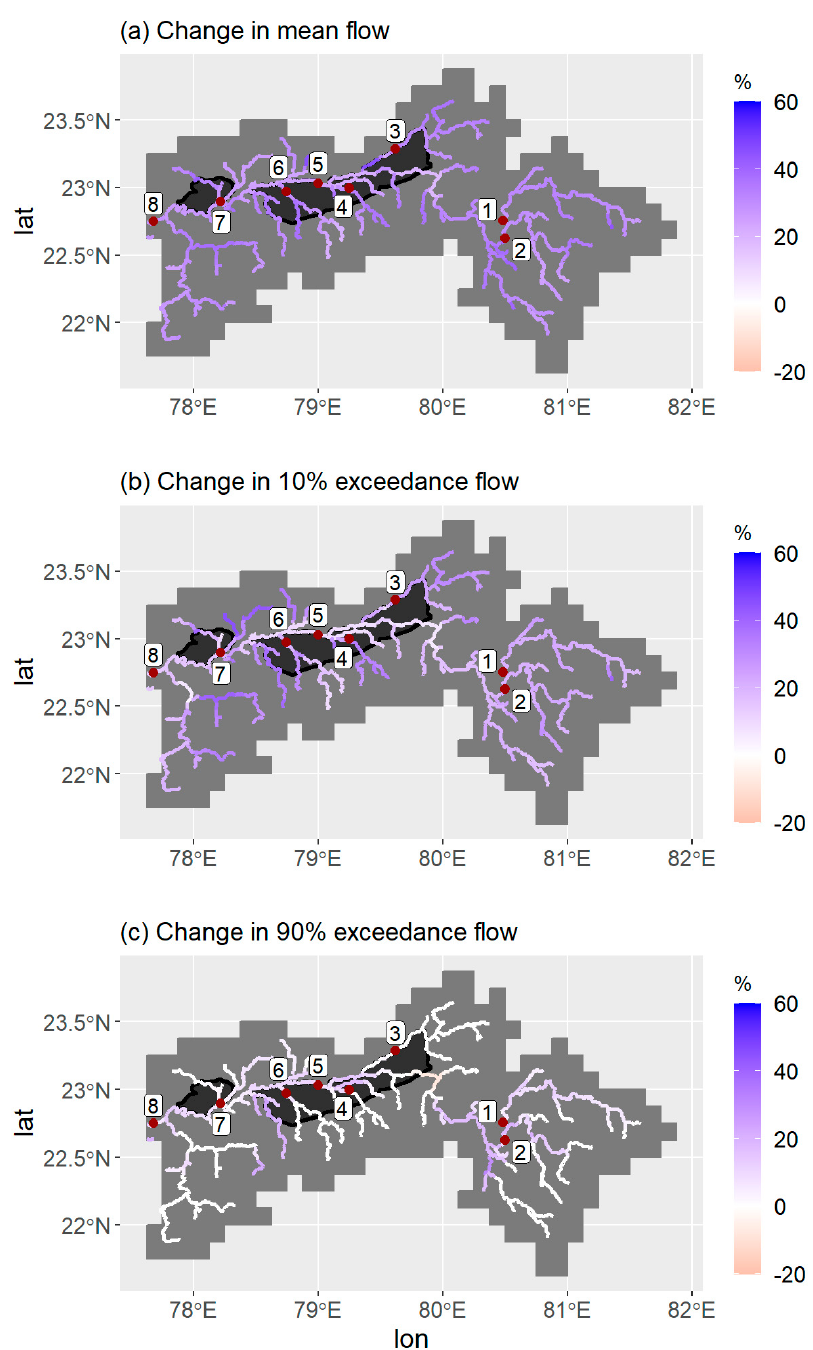
Figure 7. Percentage changes in flow between the baseline (1981–2010) and the simulated future period (2031–2060) for the Upper Narmada basin: ( a ) Change in mean flow ( b ) Change in 10% exceedance flow (Q10); ( c ) Change in 90% exceedance flow (Q90). (1) Manot; (2) Mohgaon; (3) Patan; (4) Belkheri; (5) Barmanghat; (6) Gadarwara; (7) Sandia; (8) Hoshangabad. Dark grey depicts the two command areas. Future mean flows at the 90% exceedance level (Q90) display a less significant change from the baseline, with large stretches of the river network showing only small increases in low